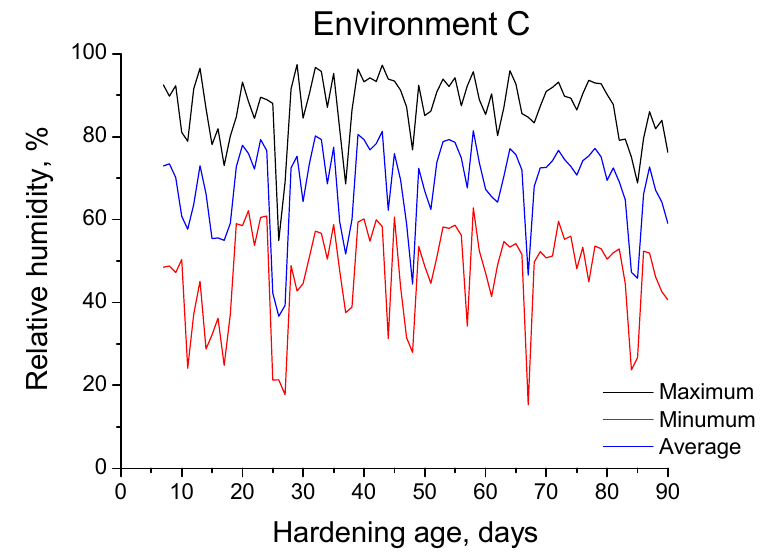
Figure 4. Daily maximum, minimum and average relative humidity registered in the station over the 90-day period of exposure to environment C.